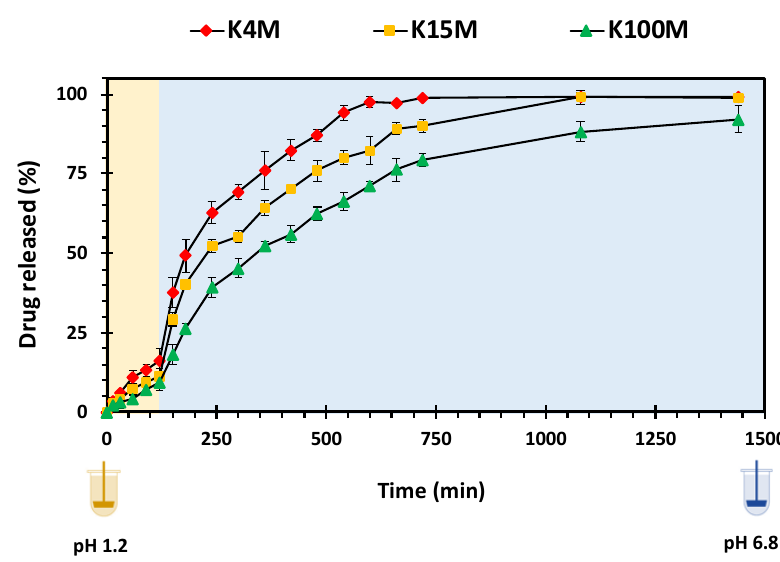
Figure 9. Drug (glipizide) release vs time profile of 3D printed HPMC matrix tablets.